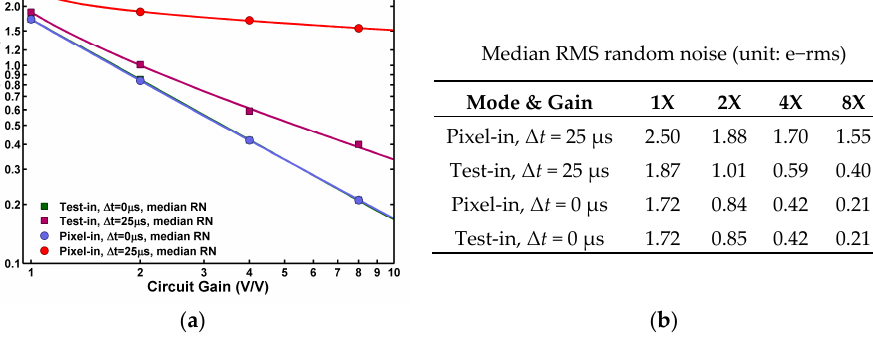
Figure 3. ( a ) The measure median RN for four-operation modes under 1X, 2X, 4X, and 8X analog gains. ( b ) The tabulated median RN of four-operation modes corresponding to the graph in (a).